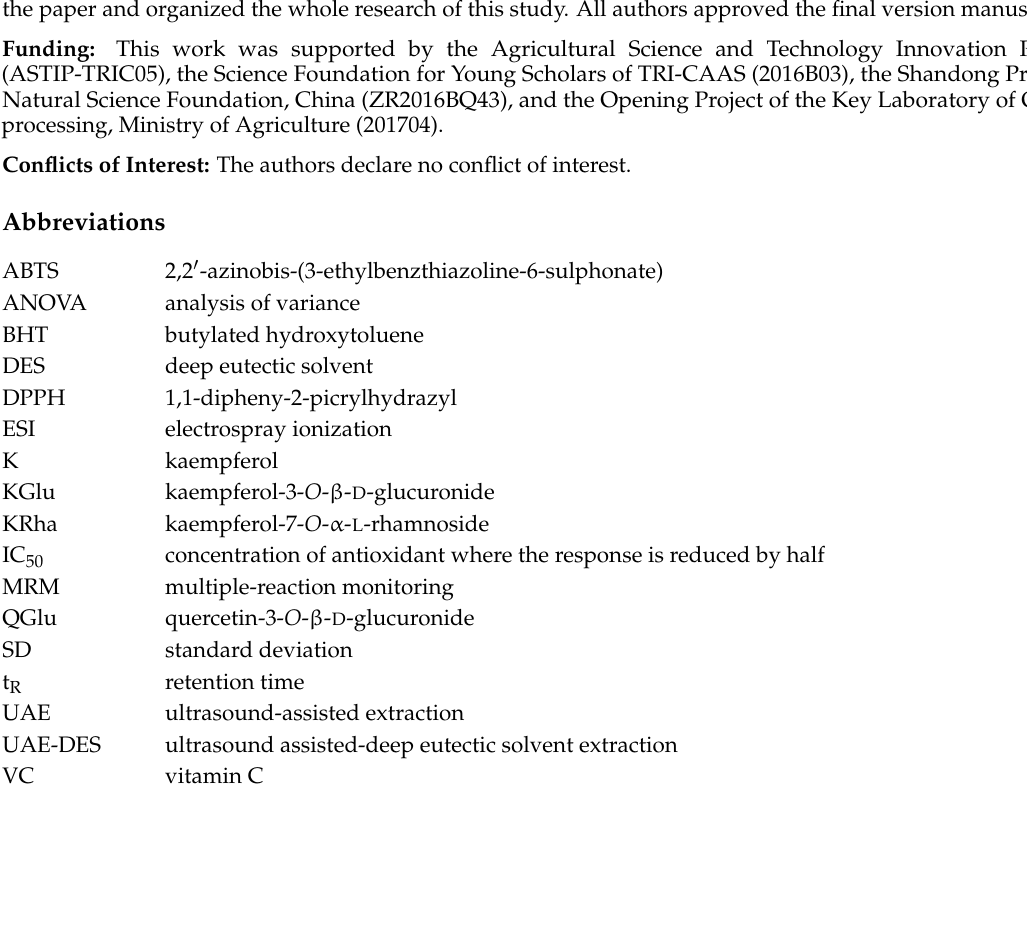
Supplementary Materials: The following are available online, Figure S1: The UPLC-MS/MS TIC spectrum of the standards ( A ) and target compounds ( B ): kaempferol (K, 10.26 min), quercetin (Q, 8.39), kaempferol-7- O - α - L -rhamnoside (KRha, 6.89 min), kaempferol-3- O - β - D -glucuronide (KGlu, 5.80), quercetin-3- O - β - D -glucuronide (QGlu, 4.83 min); Figure S2: The effects of different ratios of choline chloride/1,4-butanediol on the yields of five flavonoids; Figure S3: Linear fittings of five flavonoids; Table S1: Linear fitting equations of five